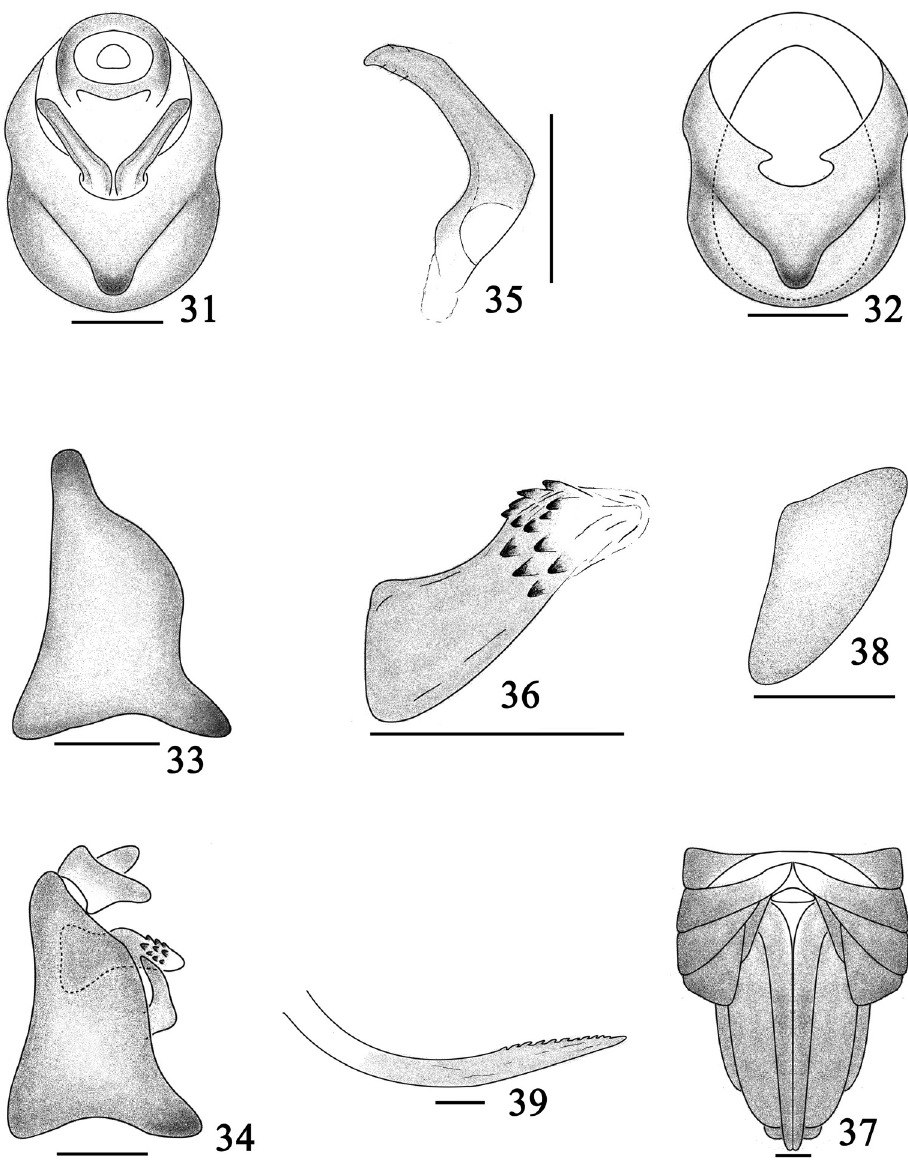
Figures 31–39. Bambusiphaga ventroprocessa sp. n. 31 Male genitalia, posterior view 32 Pygofer, posterior view 33 Same, lateral view 34 Male genitalia, lateral view 35 Genital style, posterior view 36 Aedeagus 37 Fe- male genitalia, posterior view 38 Gonocoxa VIII, posterior view 39 Gonapophysis IX. Scale bars 0.1 mm.